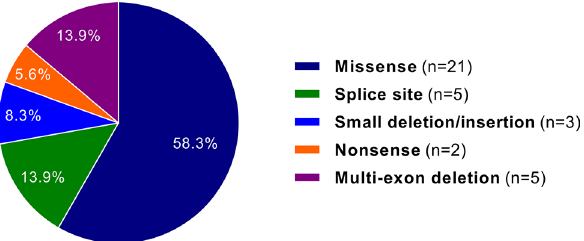
Figure 1. A representation of the different FBN1 variants in 36 index patients is